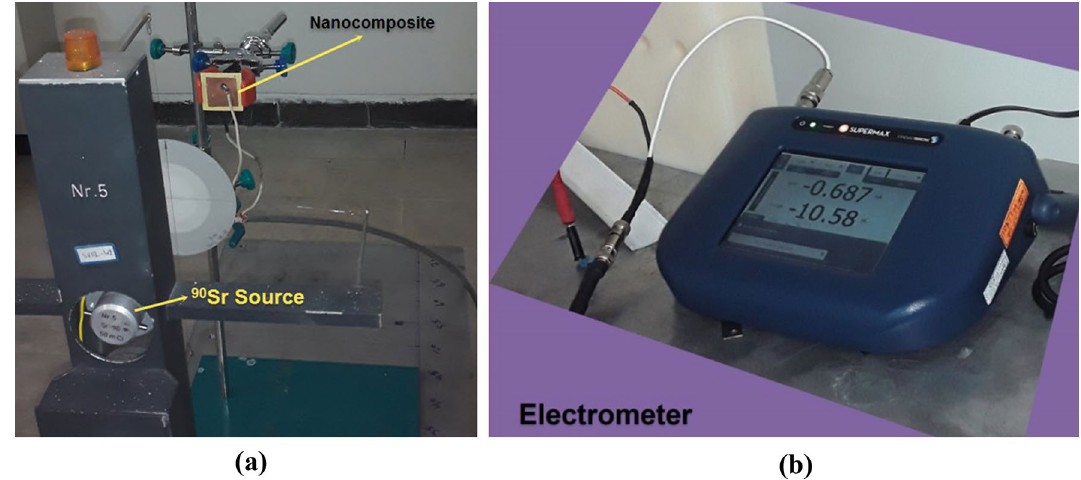
Figure 1. Measurement setup for sensing the beta-rays using ( a ) beta irradiation system (Buchler) and ( b ) Supermax Standard Imaging